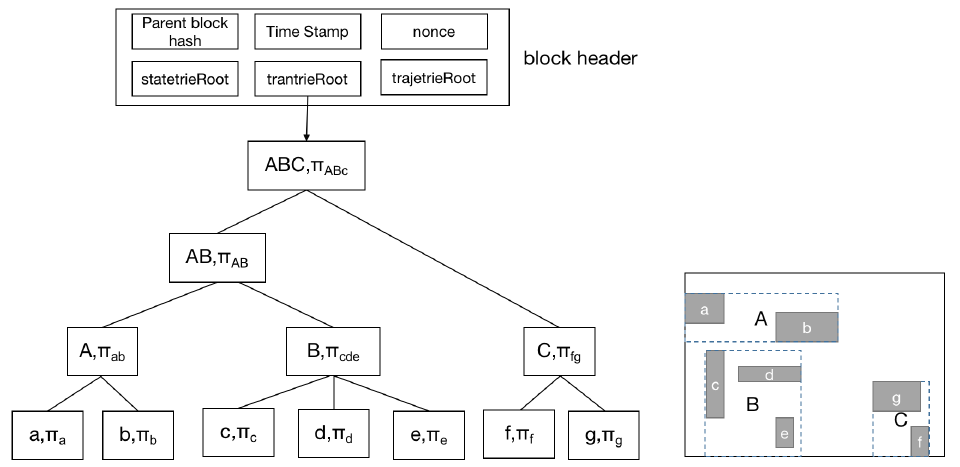
Figure 4. Transaction information stored in Verkle